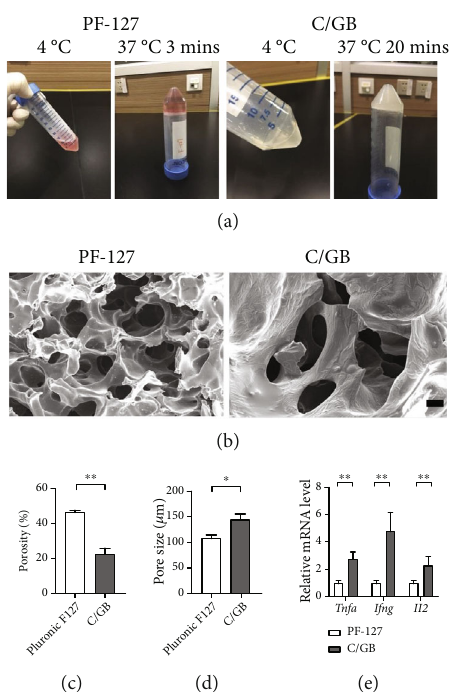
Figure 2: PF-127 hydrogel possesses larger interconnected pore and higher biocompatible capacity compared to C/GP hydrogel. (a) Photographs of PF-127 and C/GP hydrogel. (b) SEM images of PF-127 and C/GP after 24-hour freeze drying process. Scale bar = 300 μ m. (c) Quanti fi cation of porosity of PF-127 and C/GP hydrogel. Data was reported as mean ± S : E : M of 5 SEM images with 200 × magni fi cation, tested for signi fi cant di ff erence ( ∗∗ P < 0 : 01 ) using Student ’ s t -test. (d) Comparison of pore size of PF-127 and C/GB hydrogel. Results were presented as mean ± S : E : M of approximately 50 pores from 5 SEM images with 100 × magni fi cation. Signi fi cant di ff erence test was performed with Mann – Whitney rank sum test ( ∗ P < 0 : 05 ). (e) Q-PCR analyzed the relative gene expression of in fl ammatory factors ( Tnfa , Ifng , and Il2 ). Data was reported as mean ± S : E : M . Student ’ s t -test was applied for signi fi cant di ff erence ( ∗∗ P < 0 : 01 ), n = 16